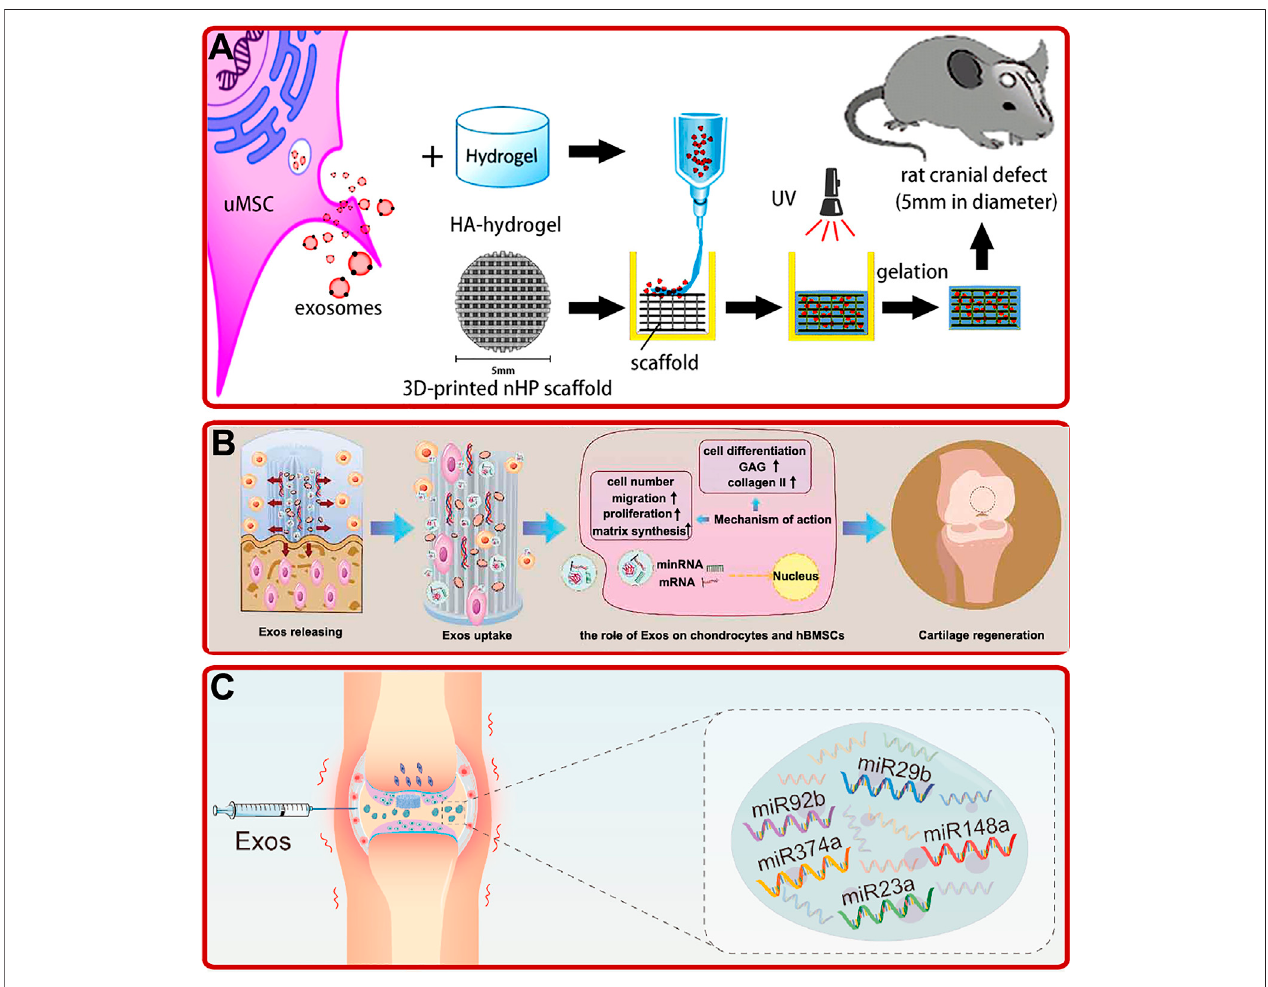
FIGURE 3 | (A) UMSC-derived exosomes combined with the HA-hydrogel and the 3D-printed nHP scaffold for cranial defect repair (Zhang Y. et al., 2021). (B) Exosomes (exos) released from hydrogel improved the migration, proliferation, and chondrogenic differentiation of hBMSCs and enhanced the formation of glycosaminoglycan (GAG), ECM, and collagen II, and thus promoted cartilage regeneration (Hu H. et al., 2020). (C) Schematic of WJMSC-derived exosomal miRNAs facilitated osteochondral regeneration (Jiang et al.,